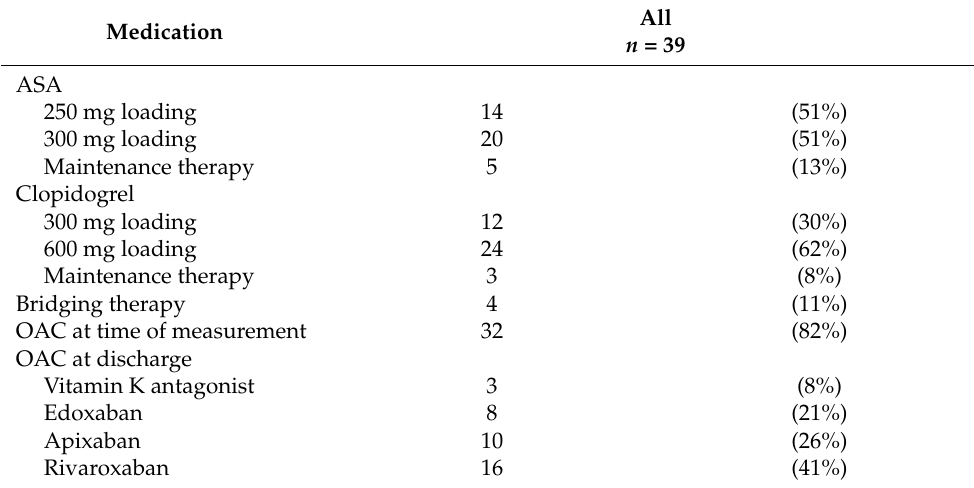
Table 2. Periprocedural medication and medication at